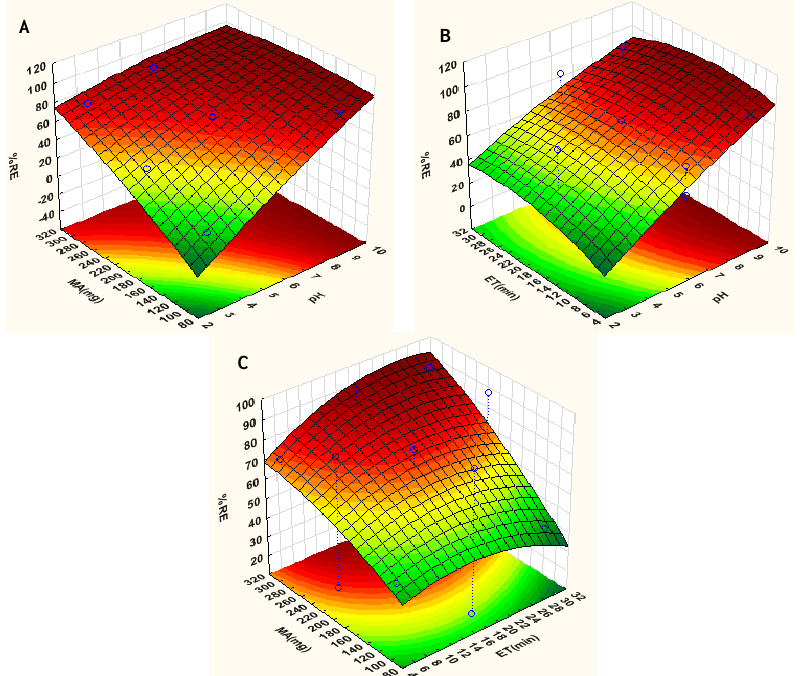
Figure 7. Response surface plot of combined effect of pH with extraction time and adsorbent mass, together with effect of adsorbent mass with extraction time on percentage recovery. ( A ) interaction between mass of adsorbent and sample pH, ( B ) interaction between extraction time and sample pH, ( C ) interaction between mass of adsorbent and extraction time